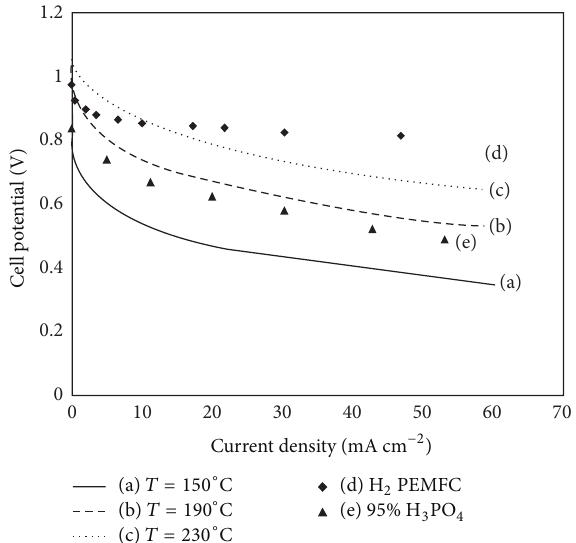
Figure 11: (a), (b), and (c) Predicted polarization curves for a direct propane/oxygen fuel cell at different operating temperatures, (d) experimental data for a typical hydrogen/oxygen PEMFC [33], and (e) experimental data for the best performed DPFC at 200 ∘ C